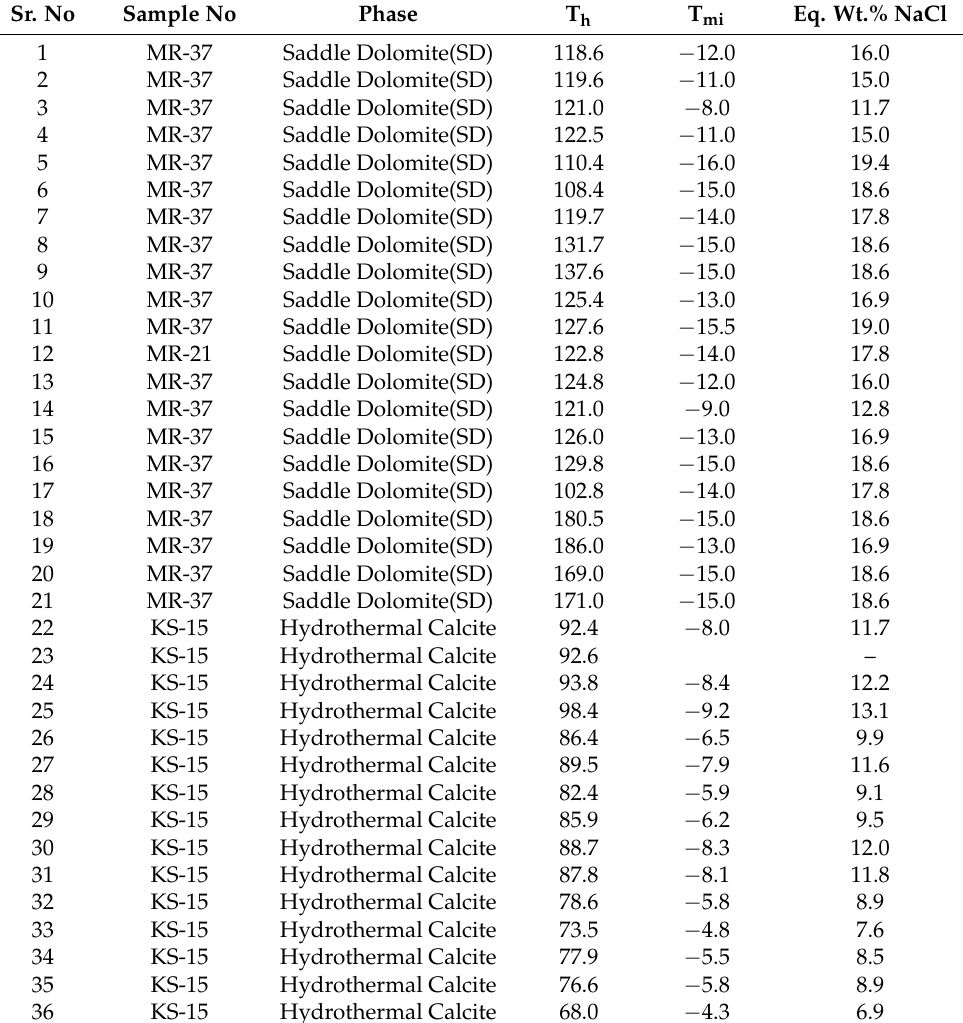
Table 3. Fluid inclusion data for dolomites and fracture-filled calcite samples of the Samana Suk